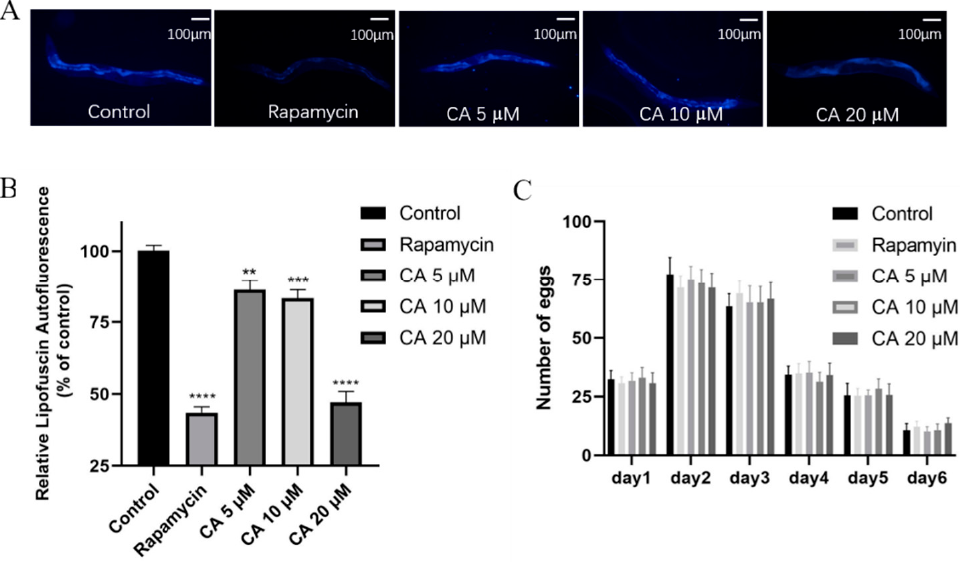
Figure 2. Effects of CA on lipofuscin and reproduction of C. elegans . Wild-type worms were treated with DMSO (control) or with rapamycin (2 nM) or CA (5, 10, 20 µ M) for 5 days, followed by detection of lipofuscin autofluorescence as shown by the representative images of worms, scale bar = 100 µ m. ( A ). Cumulative data are shown in the bar figure ( B , n > 19 worms per group, ** p = 0.0016, *** p = 0.0001, **** p < 0.0001). Egg production rates were recorded ( C , n = 10 worms per group, p > 0.05).